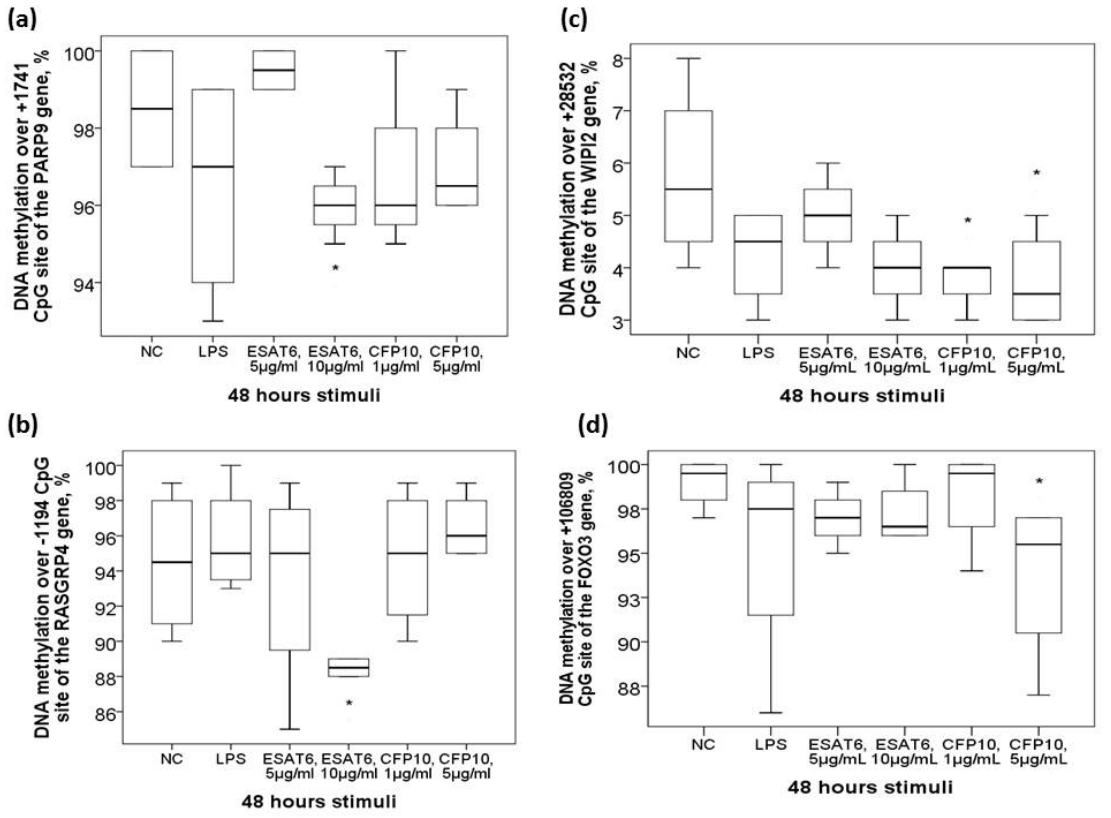
Figure 5. Aberrant DNA methylation levels of the candidate genes in response to in vitro mycobacterium tuberculosis-specific antigen stimuli. In vitro treatment of the THP-1 cells with ESAT-6 resulted in decreased DNA methylation levels over ( a )+1741 CpG site of the PARP9 gene and ( b ) -1194 CpG site of the RASGRP4 gene. In vitro treatment of the THP-1 cells with CFP-10 resulted in decreased DNA methylation levels over ( c ) +28582 CpG site of the WIPI2 gene and ( d ) +106809 CpG site of the FOXO3 gene. *Compared between normal control (NC) and Mtb-specific antigen stimuli by Mann-Whitney U-test .